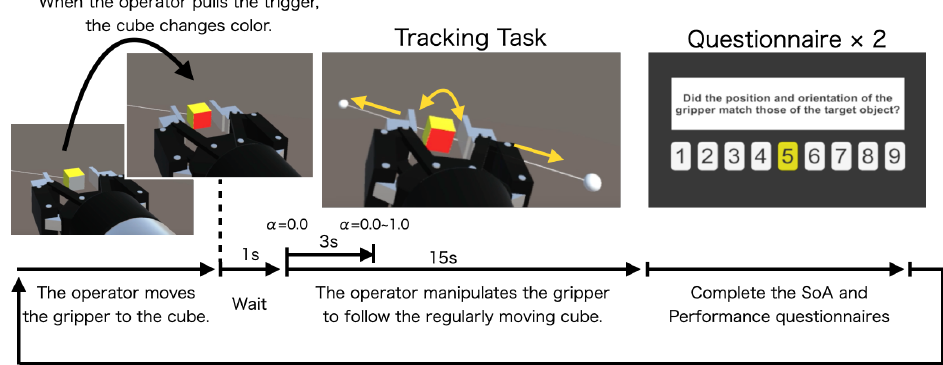
Figure 5. Procedure for one set of the tracking